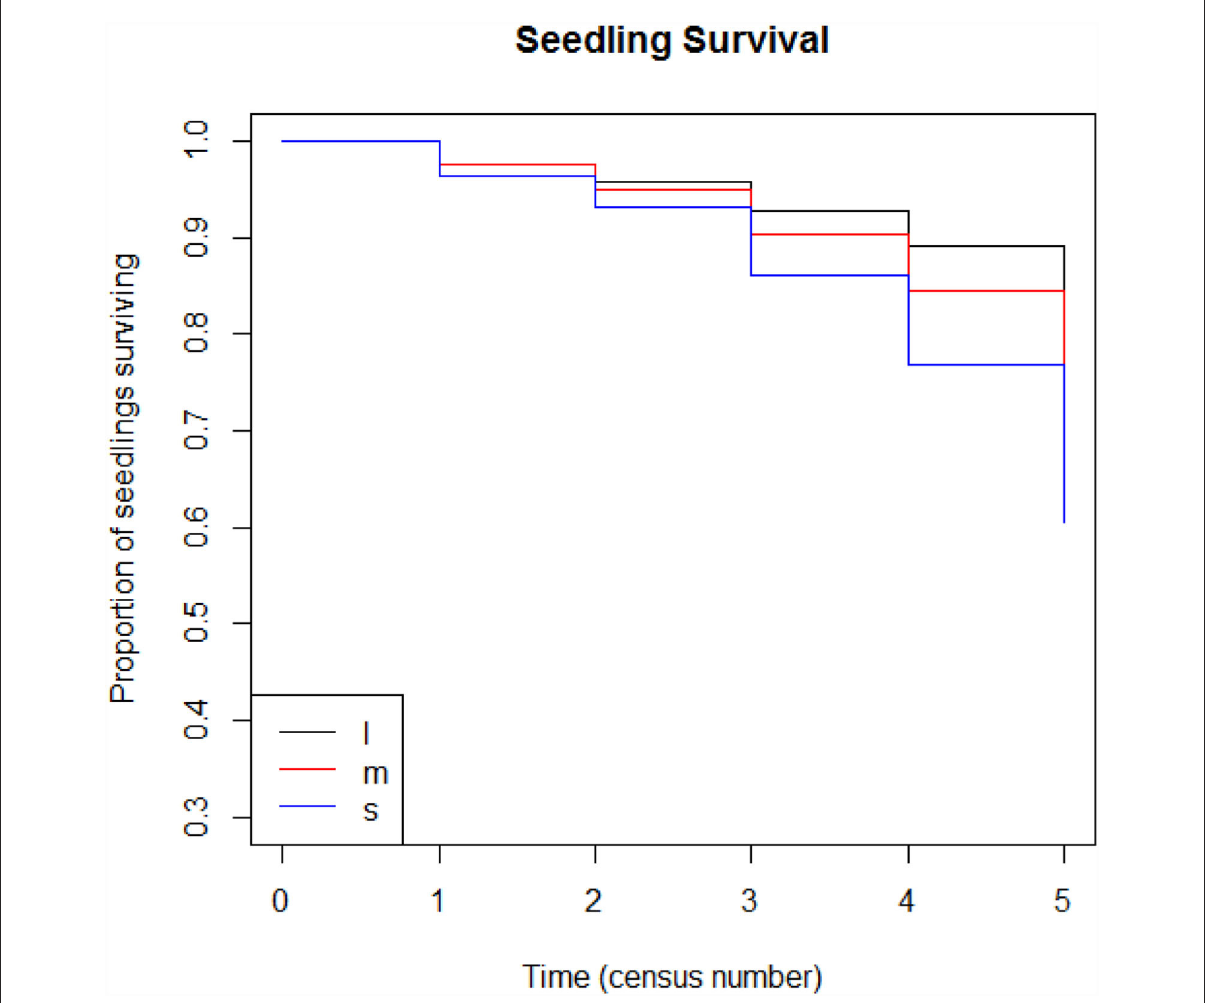
FIGURE9 Seedling survival model for seedlings in four second-growth plots during six census periods by seed size: l = y > 15mm, m = 6 < y ≤ 15, s = y ≤ 6mm.